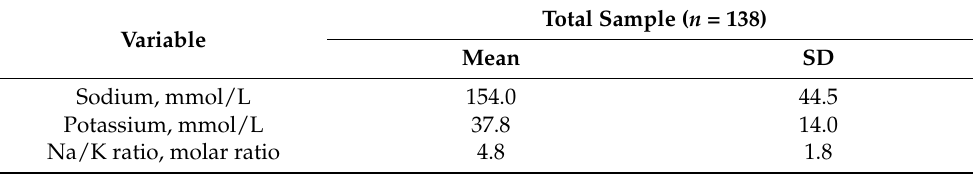
Table 2. Urinary sodium, potassium, and Na/K ratio of the study